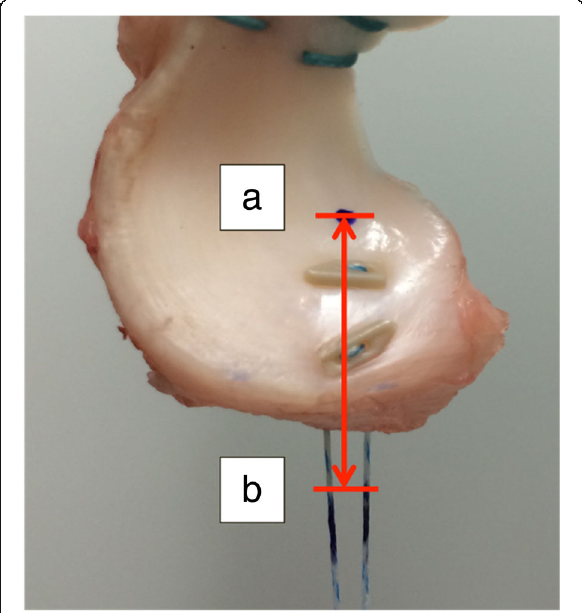
Fig. 3 Measurement of displacement. One dot was marked on the meniscus ( a ). The reference point was fixed at 10 mm below the